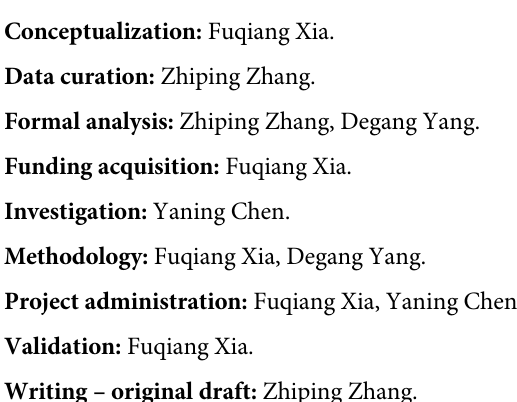
S1 Table. Single-index assessment results. S2 Table. Comprehensive environmental assessment. S3 Table. Comparative analysis. S4 Table. Basic